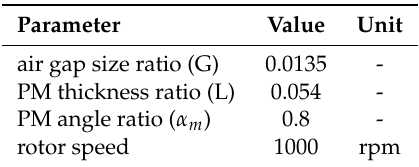
Table 3. Experimental model input parameters.